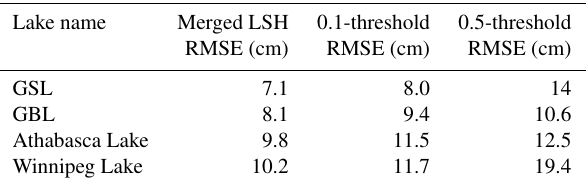
Table 4. Improvements in merged LSH compared with the LSH based on a single threshold validated against in situ water